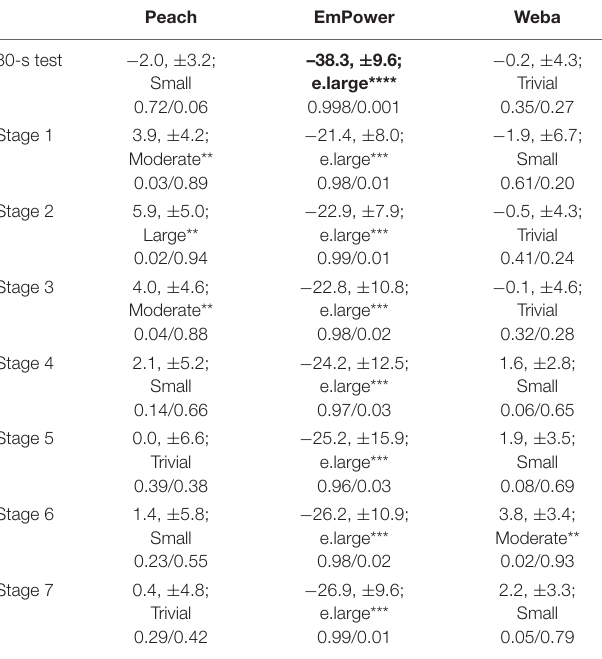
TABLE 3 | Technical (residual) error of measurement representing session-to-session error for mean power recorded by Peach, EmPower, Weba, and the Concept2. Data are SD (%), ± 90% compatibility limits, with observed magnitude and p -values for the superiority test ( p +